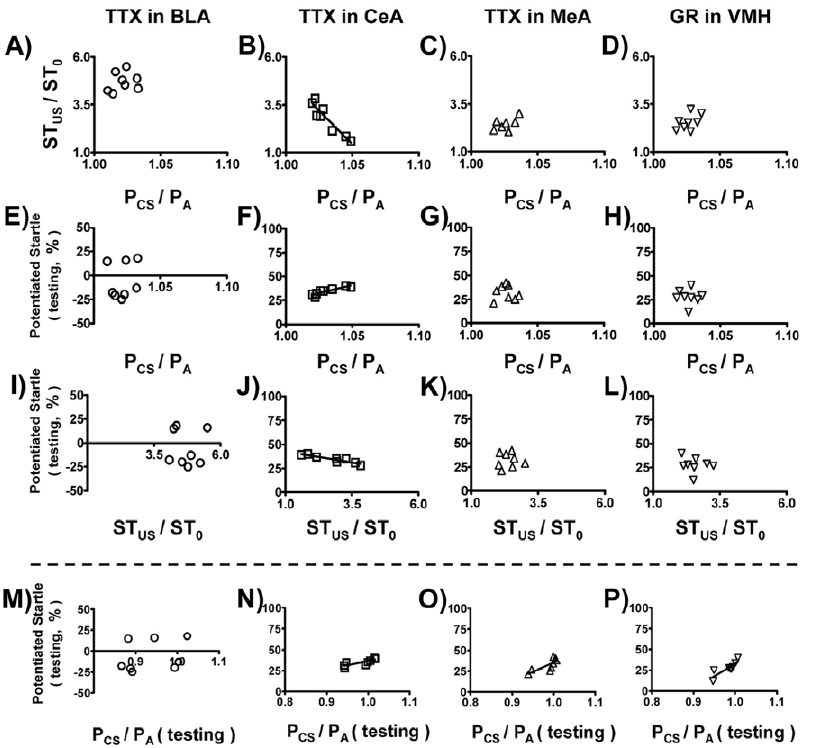
Figure 9. Pharmacological interventions to locally block one or both of the fear learning pathways and the consequences on the fear-potentiated startle. The blockers were locally injected into BLA, CeA, MeA or VMH to block local neuron activity before training session. Results were analyzed by Pearson’s correlation analysis for individual group. Panels with line marks indicate significant correlation between the ordinate and the abscissa. Results from measuring P CS /P A values in the training session indicated that the MeA/VMH-mediated fear learning pathway, but not the CeA-mediated pathway, was BP-related (A–L). However, local blockages in CeA, MeA, or VMH all retained partial fear learning and memory (M–P).